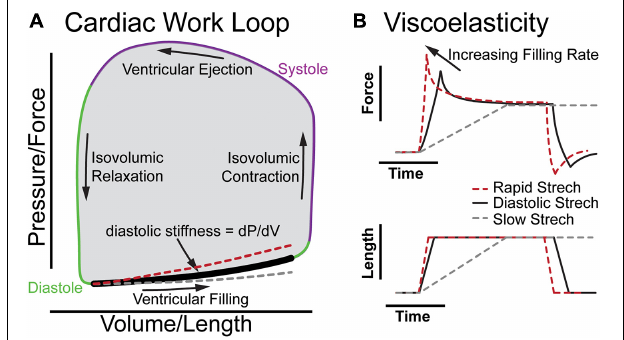
FIGURE 1 | The role of viscoelasticity in determining diastolic compliance. (A) Illustration of cardiac work loop with diastolic filling and effective stiffness. The red and gray curves indicate increased or decreased filling rate, respectively. (B) The associated force vs. time and length vs. time plots for a diastolic stretch and an isometric hold to reveal viscoelastic